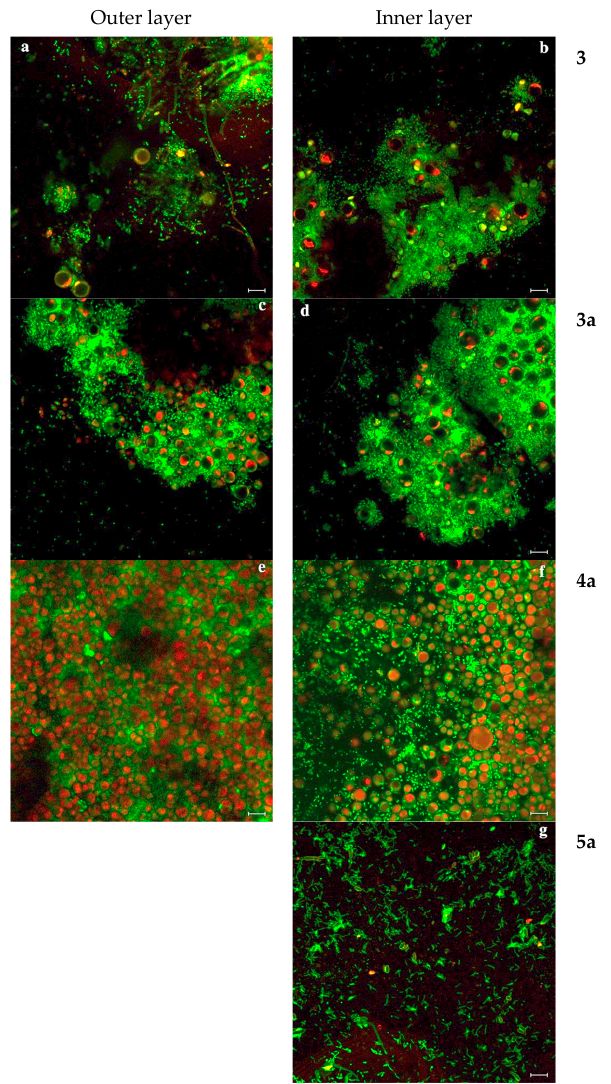
Figure 9. Biofilm behavior on marble probes after incubation for 90 days. Inner and outer layers show a diverse vertical distribution of microbial members of the biofilm according to the treatment. The different groups are well recognizable being algae colored in red, bacteria in green, while black fungi appear as black areas between the colored cells. Outer and inner layers of biofilm: ( a , b ) in the samples treated with 3 : a shrinkage of biofilm with stressed algae surrounded by bacteria is observed; ( c , d ) samples treated with 3a : the biofilm is reduced compared to the control, algae are in sufference, as demonstrated by the reduced intensity of red color of algal cells and by the increasing of surrounding bacteria; ( e , f ) on samples treated with 4a an healthy biofilm is well evident; ( g ) inner layer of sample 5a ; in this layer only residual cells are visible. Detailed explanations are given in the text. Bar is 10 μ m.